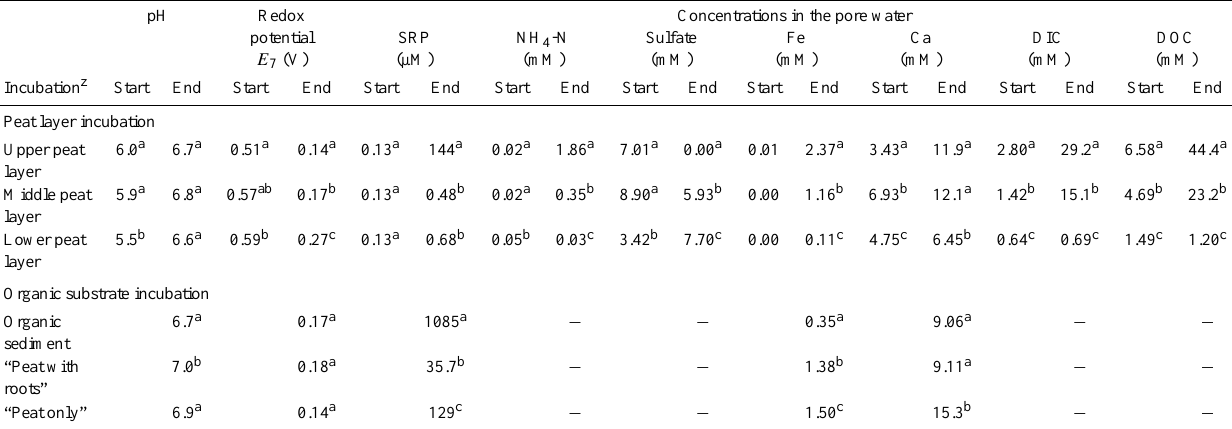
Table 3. Characterization of pore water chemistry for the peat layer incubation and the organic substrate incubation (letters indicate differ- ences between the treatments, p < 0 .